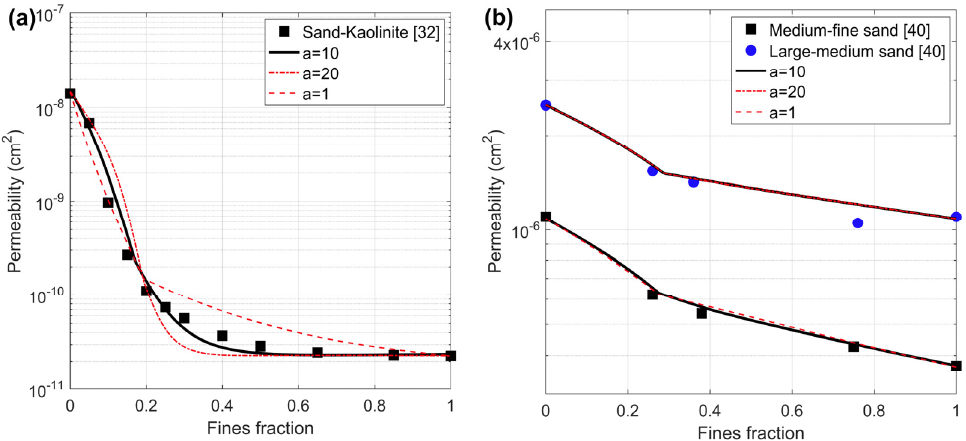
Figure 11. Permeability as function of fines fraction for ( a ) sand–Kaolinite mixtures from [32], and ( b ) binary graded sand mixtures [40]. The different curves were produced using the current model ((13)–(18) and (19)–(21)) for different a values. The average value reported based on all mixtures examined is 10 (black solid curve) while the red curves represent the prediction at different a values. No obvious differences are noticed except in the presence of clay in the mixture.